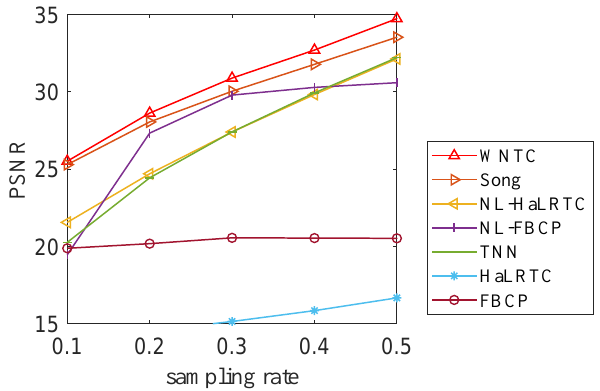
Figure 4. Curves of PSNR values of different